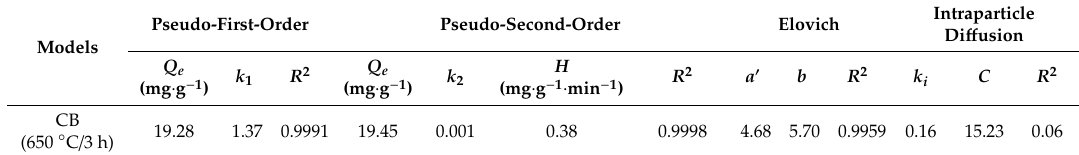
Table 4. Adsorption kinetics fitting parameters of CB for NO 3 − .